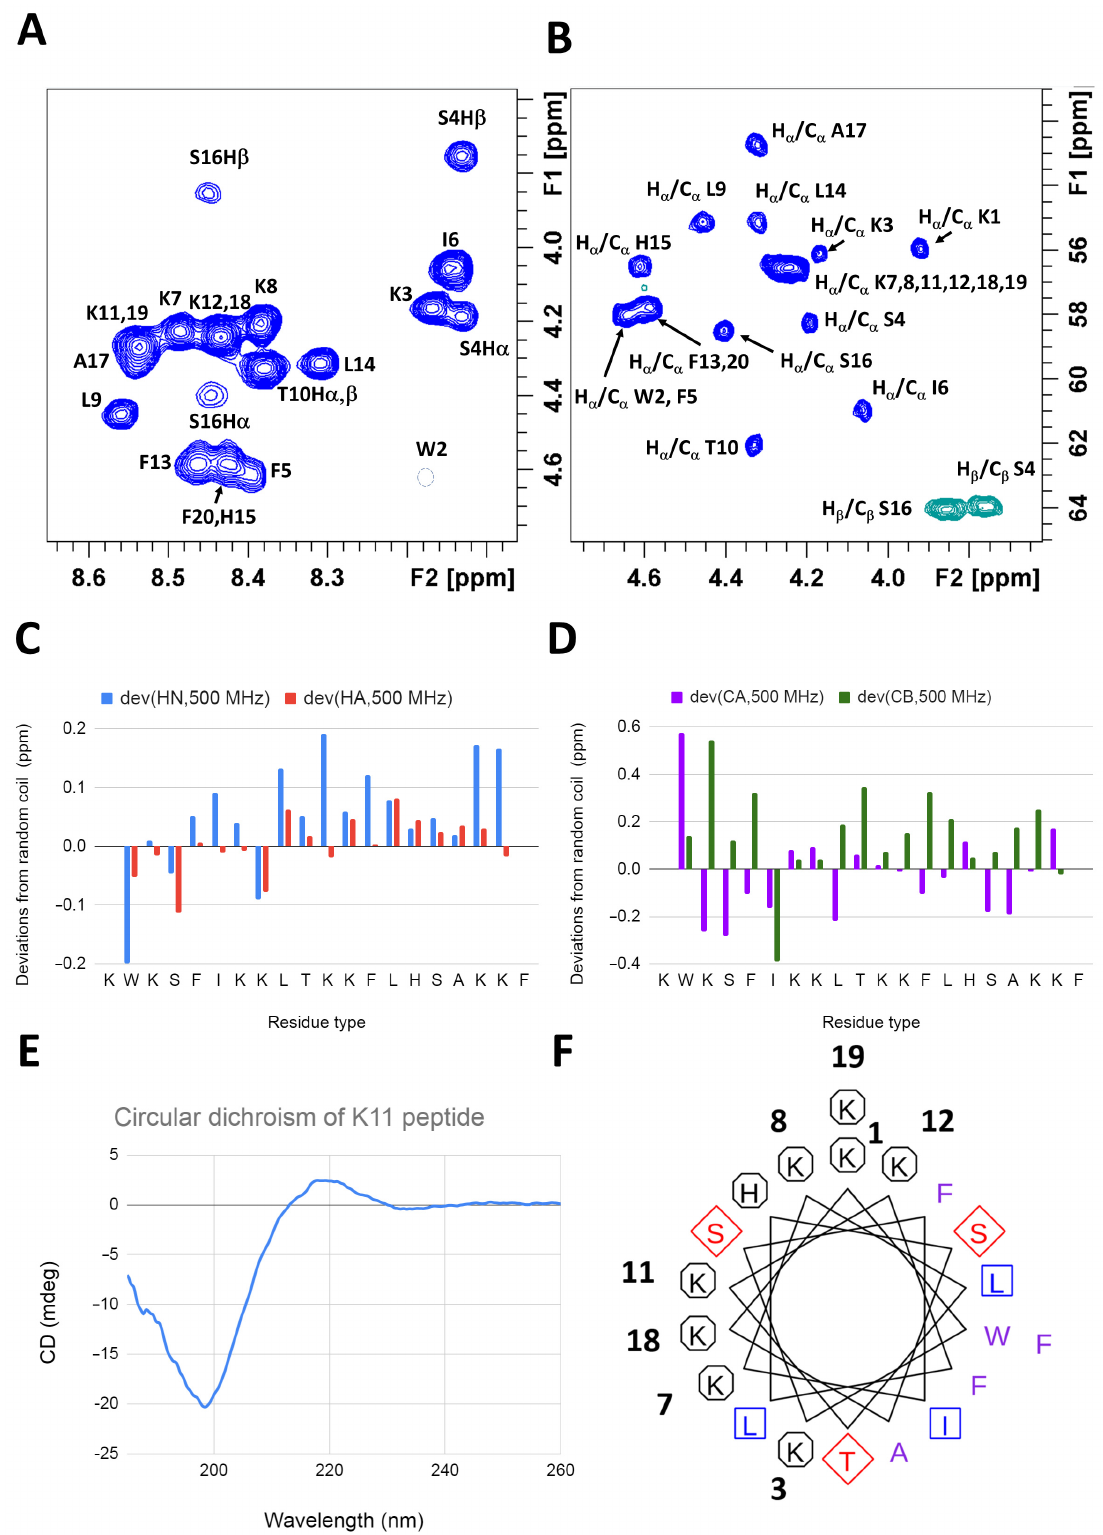
Figure 1. ( A , B ) The 1 H and 13 C NMR assignment of K11 on the amide/H α ( A ) and side chain ( B ) regions of 1 H, 1 H-TOCSY and 1 H, 13 C-HSQC spectrum, respectively. ( C , D ) Chemical shift deviations from random coil values of amide HN and H α protons ( C ) and C α and C β carbons ( D ); ( E ) CD spectrum of K11 in solution; ( F ) helical wheel showing the disposition of side chains in alpha helical conformation.